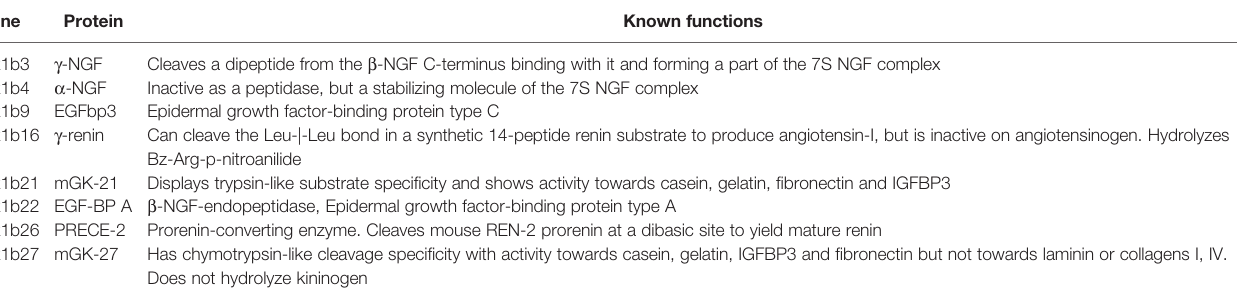
TABLE 1 | Members of the mouse Kallikrein 1-related proteases with reduced or additional known activities. Gene Protein Known